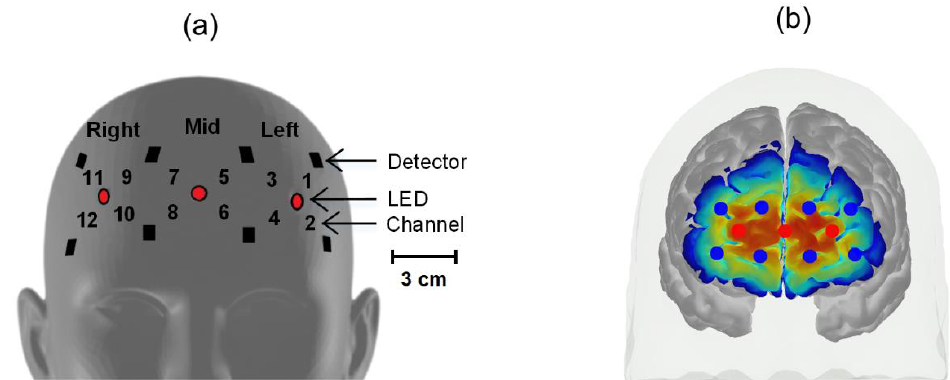
Figure 3. ( a ) Photodetector placement and channel positions. All the distances between the detector and LED are the same, 3 cm. The distances between the adjacent detectors are 5.5 cm horizontally and 4.5 cm vertically. Similarly, the distance between adjacent LEDs is 5.5 cm. ( b ) Sensitivity map for the depicted channel arrangement.